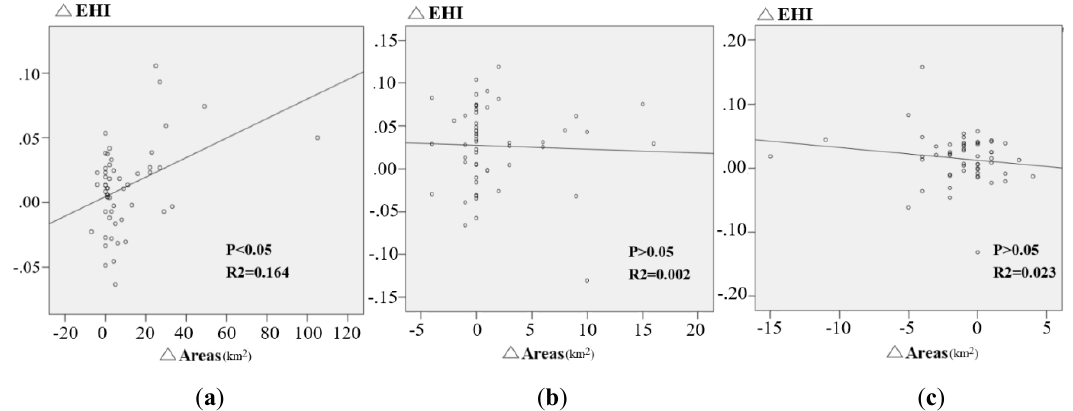
Figure 9. Relationship between the EHI and ecological restoration areas from 2000 to 2015 at the county level, ∆ EHI represents changes in the EHI: ( a ) 2000–2005; ( b ) 2005–2010; ( c ) 2010–2015.